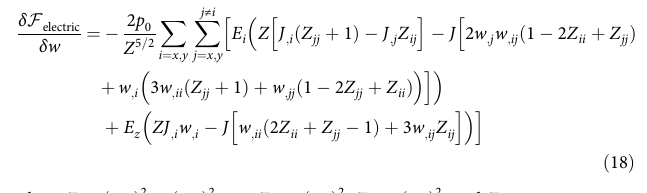
Table 2 Geometric embeddings